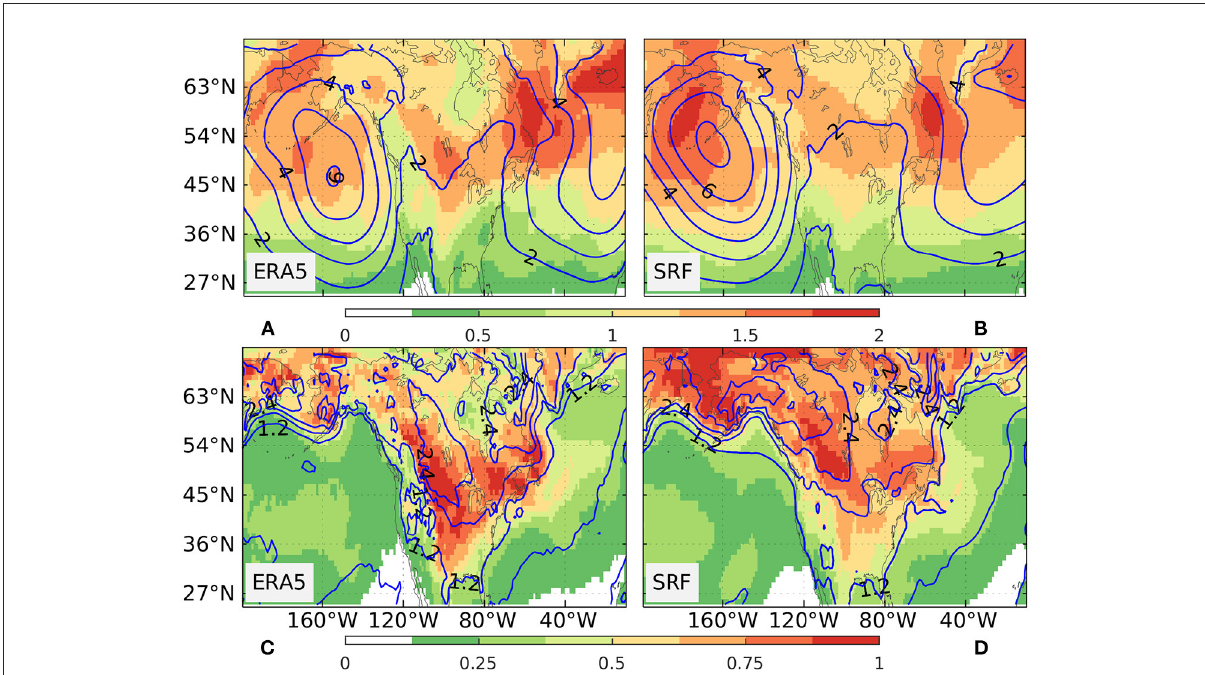
FIGURE3 The standard deviation of seasonal SLP anomalies (contour, units in hPa) and Extratropical Storm Track Index (shading, units in hPa) for DJF during 1992–2022 from (A) ERA5 data and (B) SRF. The standard deviation of seasonal SAT anomalies (contour, units in K) and TSI (shading, units in K) for DJF during 1992–2022 from (C) ERA5 data and (D)